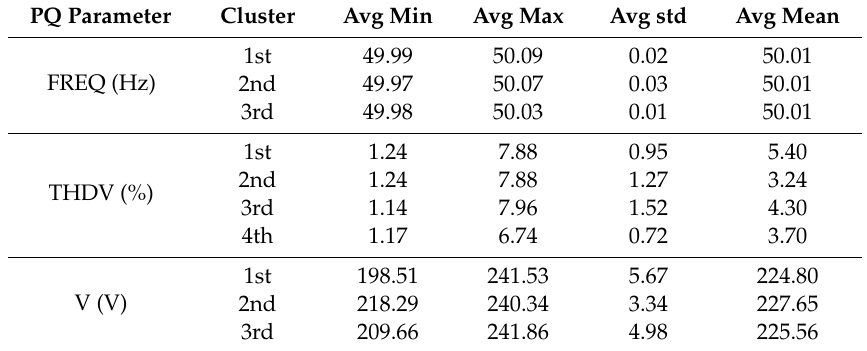
Table 8. Statistical description of the PQ parameters of the obtained clusters for system 50% SoC. PQ Parameter